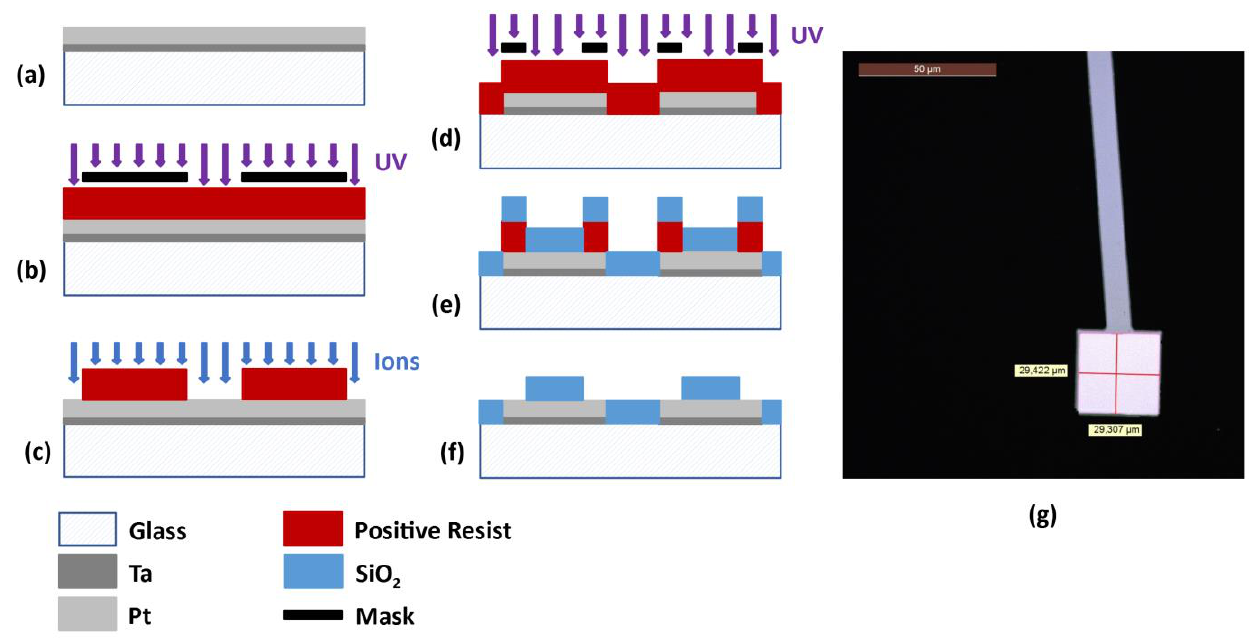
Figure 10. The main microelectrode fabrication steps. ( a ) Deposition of Ta (10 nm) and Pt (110 nm) layers on a glass substrate using a PVD process. ( b ) Positive resist deposition and insolation through a mask. ( c ) Resist development and IBE of Pt and Ta. ( d ) Deposition and insolation of a positive resist for lift-off. ( e ) Resist development and deposition of SiO 2 layer (120 nm) using a PVD process. ( f ) Resist lift-off. ( g ) Image of a microelectrode. The lighter square area corresponds to the sensitive surface not covered by SiO 2 .